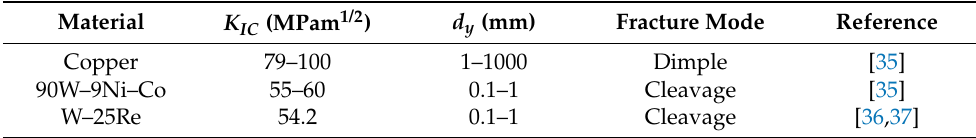
Table 9. Fracture toughness K IC and damage tolerance d y of the three kinds of materials.